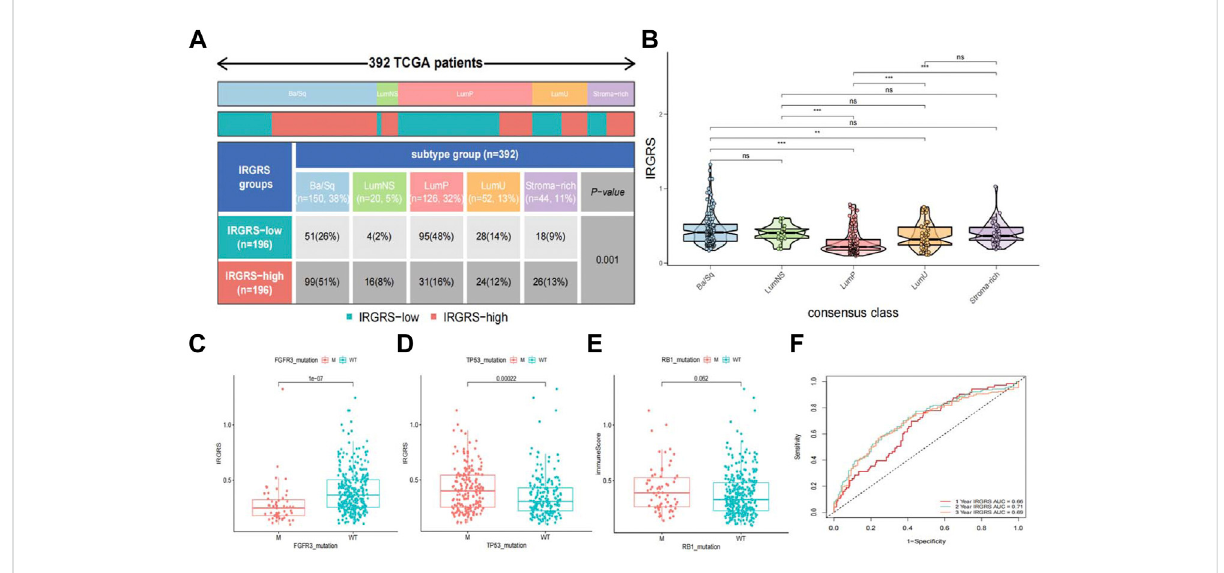
FIGURE 6 Relationship between molecular classi fi cation and IRGRS (A) . Heatmap and table showing the distribution of bladder cancer consensus molecularsubtypesbetweentheIRGRSandsubgroupsinTCGAdataset. (B) .FivebladdercancermolecularsubtypesandtheircorrespondingIRGRS. (C) . Comparison of IRGRS betweenthe FGFR3 mutated groups and FGFR3 wild type groups.M = mutated, WT = wild type. (D) . Comparison of IRGRS between the TP53 mutated groups and TP53 wild type groups. (E) Comparison of IRGRS between the RB1 mutated groups and RB1 wild type groups. (F) . Time dependent ROC curve analysis of survival prediction by the